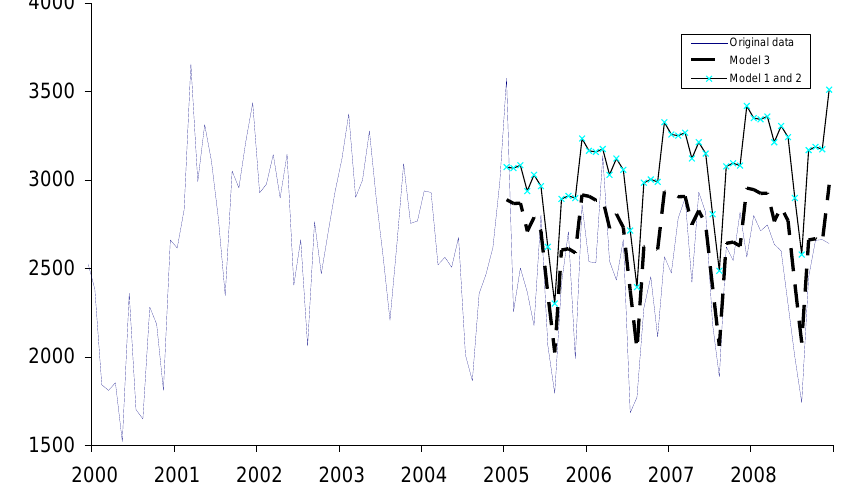
Figure 5 Out-of-sample